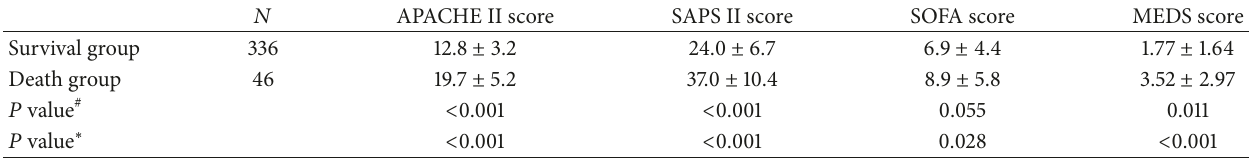
Table 2: Comparison of severity-of-disease indicators between the survival and death groups of patients with AECOPD.